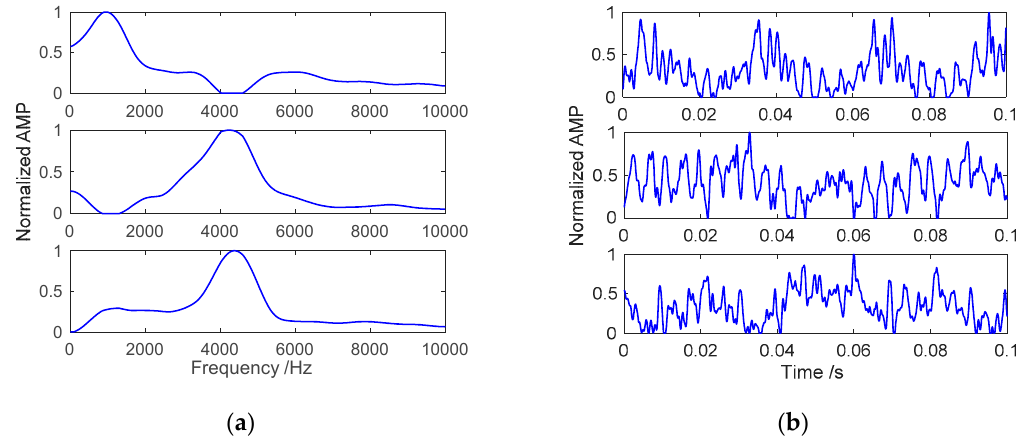
Figure 6. Decomposed factors of SNTF: ( a ) Frequency matrix A ; ( b ) time matrix B .